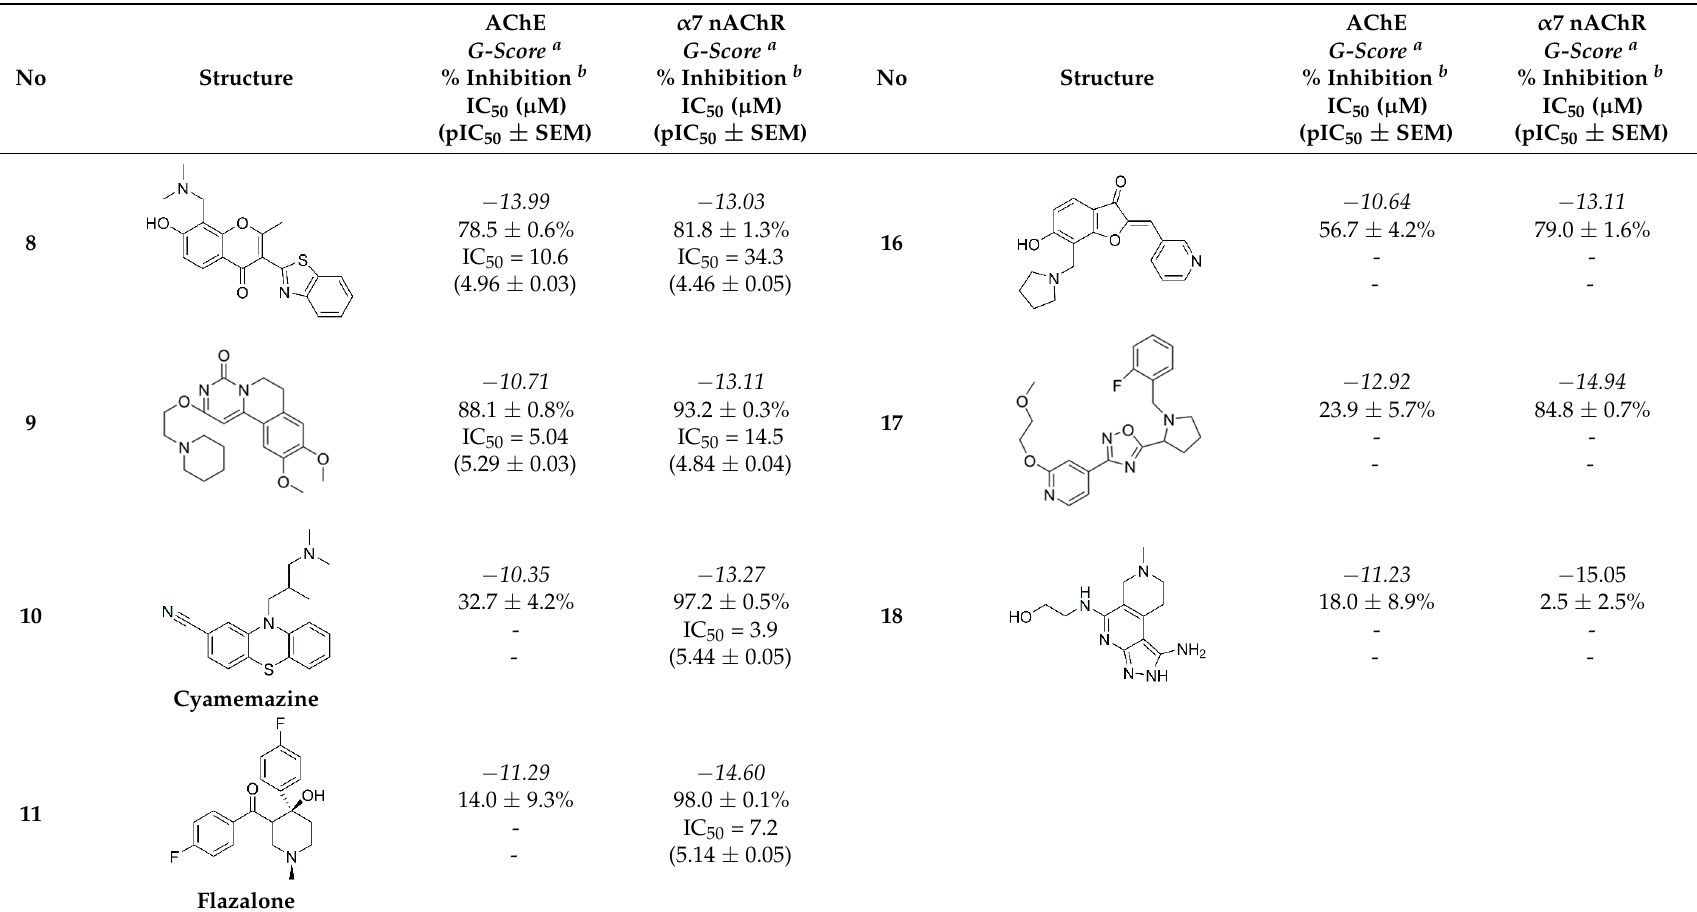
Table 1. Structures and corresponding docking scores and in vitro activities of selected hits and reference compounds. All compounds except references galantamine and physostigmine were initially evaluated at 100 µM. For compounds exceeding 70% inhibition at the AChE and 90% at the α 7 nAChR, IC 50 values were determined. No Structure